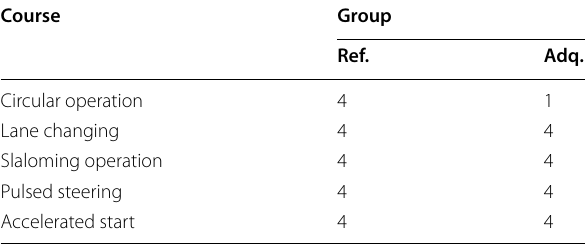
Table 4 Number of successful platooning vehicles on experiment for validation of appropriate sensor